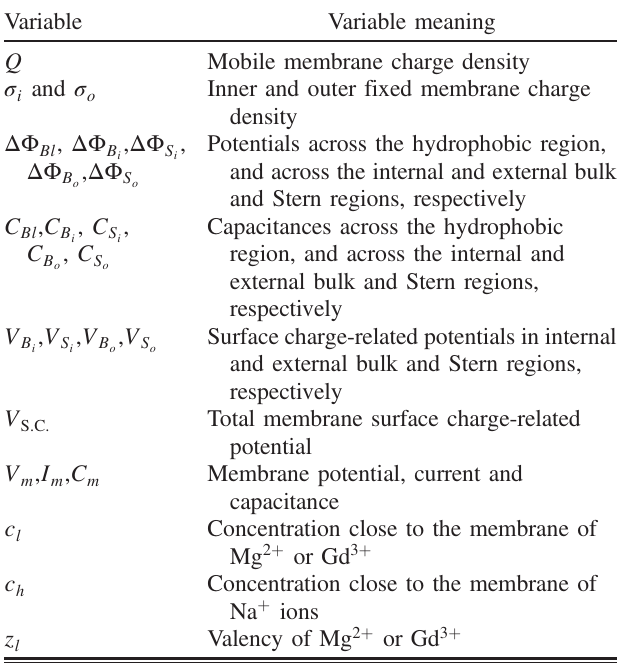
TABLE I. Variables used in the theoretical framework.